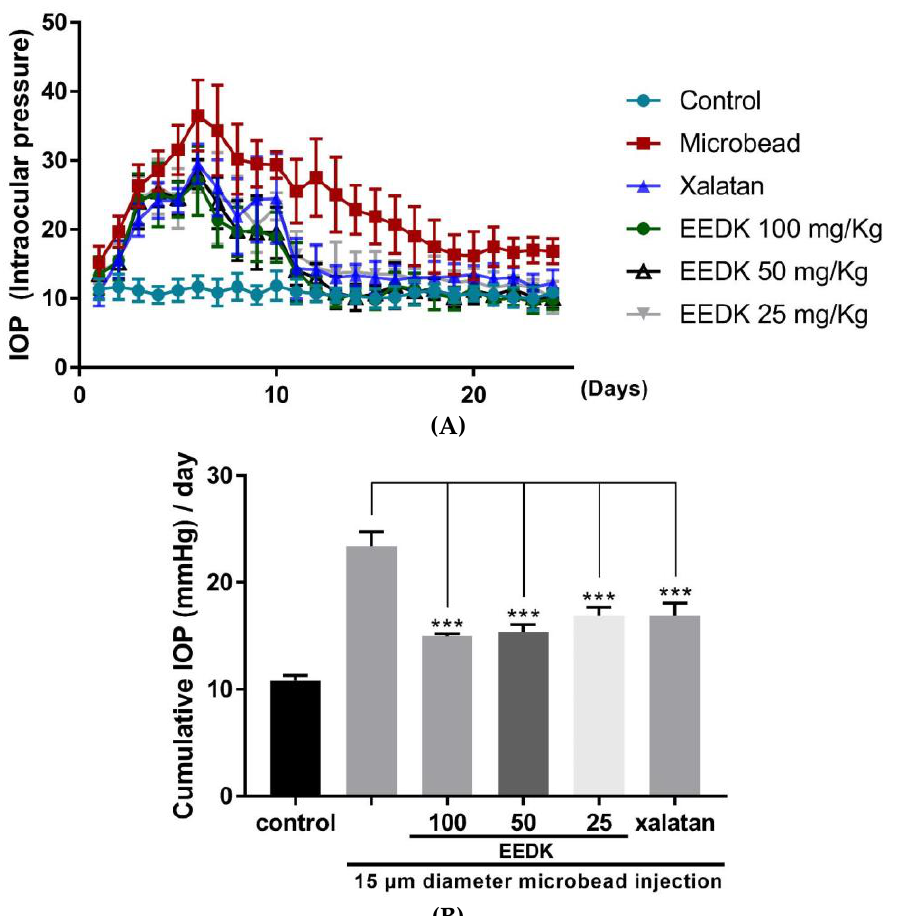
Figure 1. Effect of Ethanol Extract of Diospyros kaki (EEDK) on elevated intraocular pressure (IOP) in microbeads-induced ocular hypertension (OHT) mice. ( A ) Assessment of IOP elevation after microbeads injection. Values represent the mean ± S.E.M. for 6 animals. ( B ) Comparison of cumulative IOP value per day in experimental and control groups. Error bars represent standard error of the mean, *** p < 0.001.